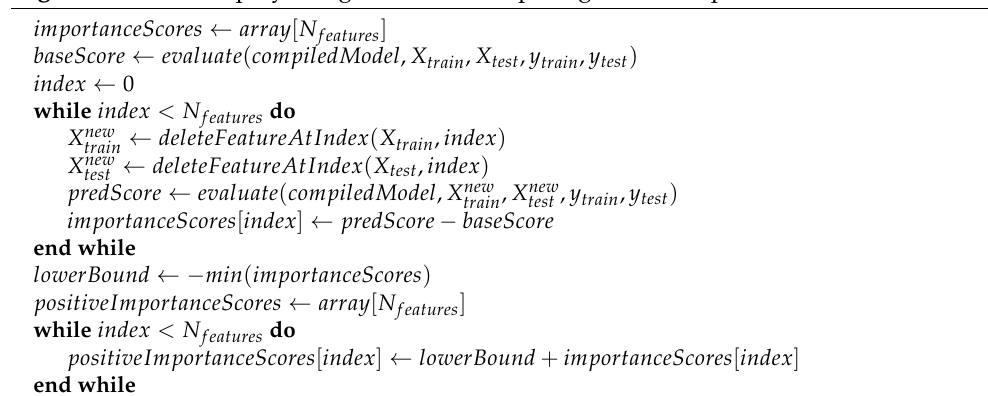
Algorithm 1 The employed algorithm for computing feature